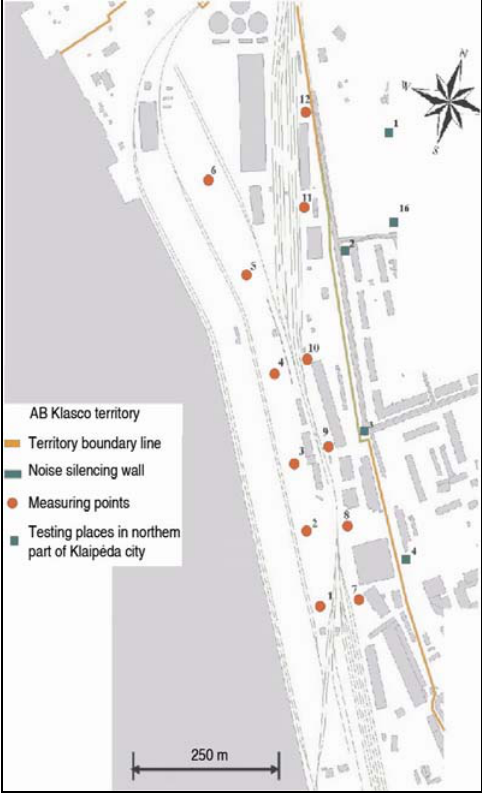
Fig 1 . Points of measuring air dustiness in the territory of Klaip ė da